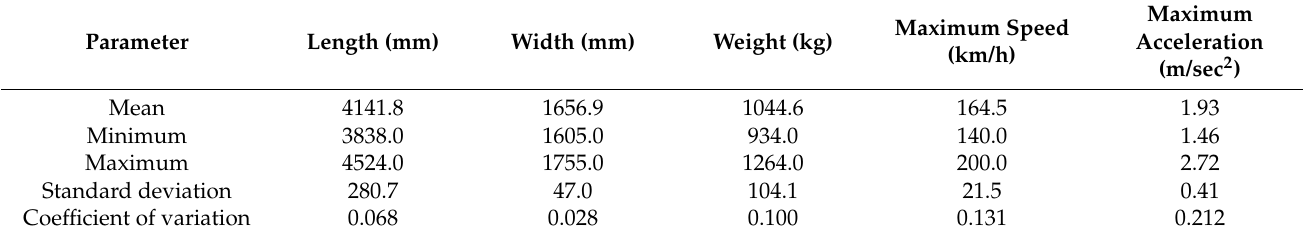
Table 6. Calibrated physical characteristics of a standard passenger car unit.